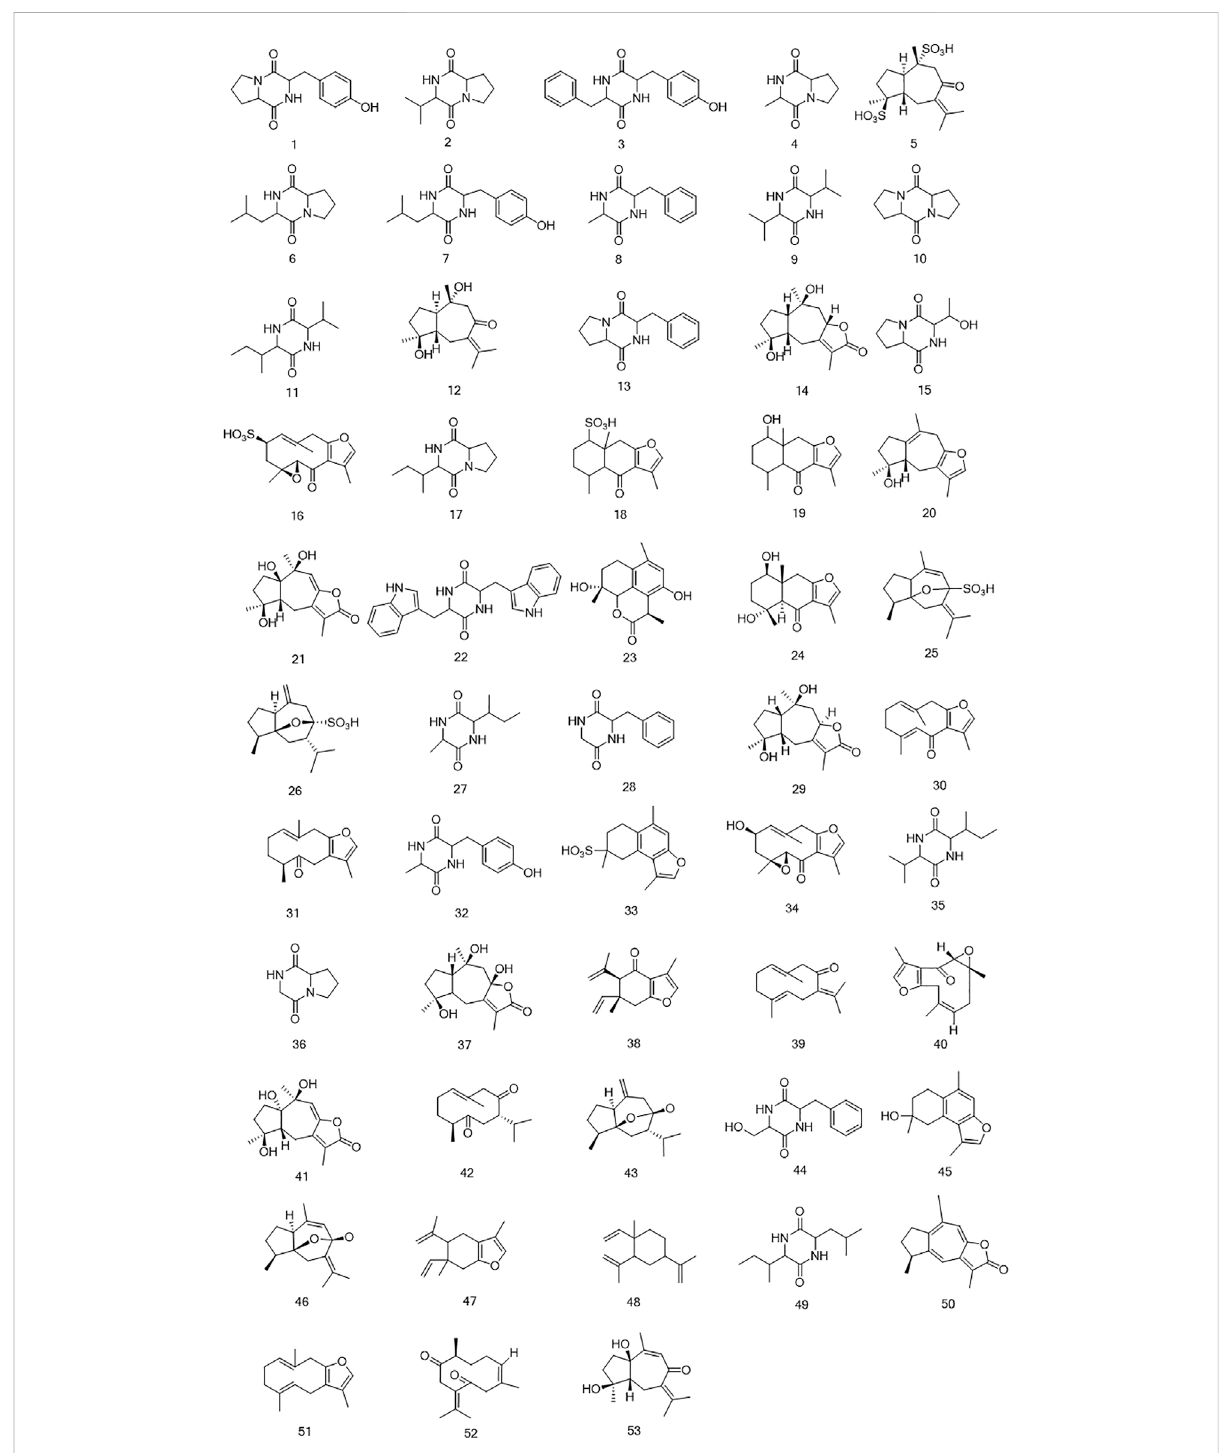
FIGURE 6 The structures of sesquiterpenoids and cyclic dipeptides identi fi ed in CR-SR, CR, and SR